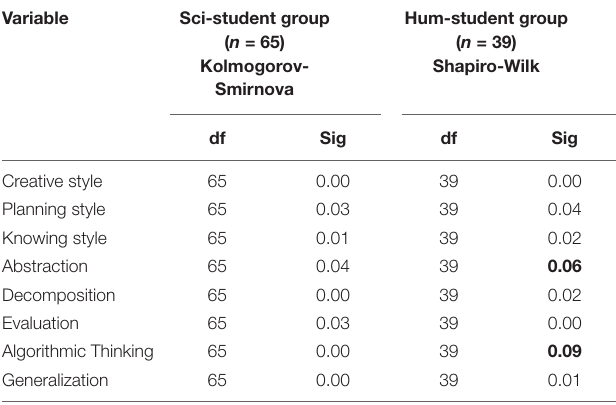
Bold values indicate p-values > 0.05, which means that the variable passed the normality